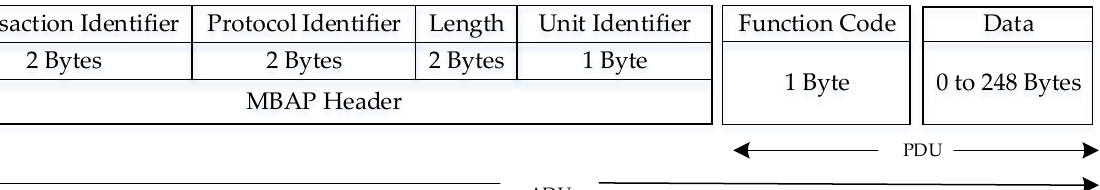
Figure 2. The frame structure of the Modbus TCP in the data link layer.